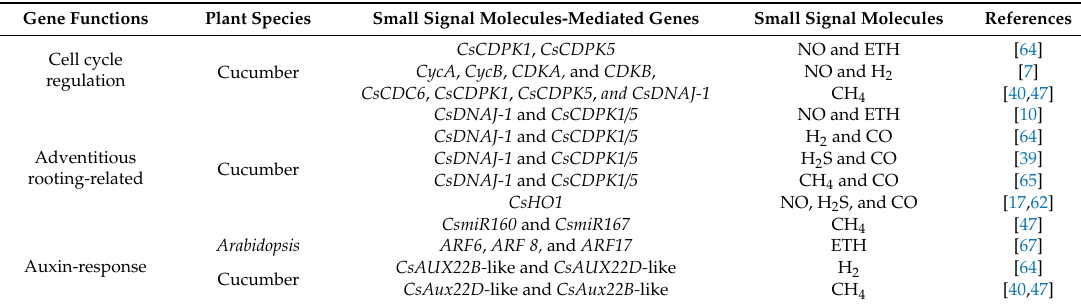
Table 3. Overview of gene regulation by small-molecule compounds during AR formation and